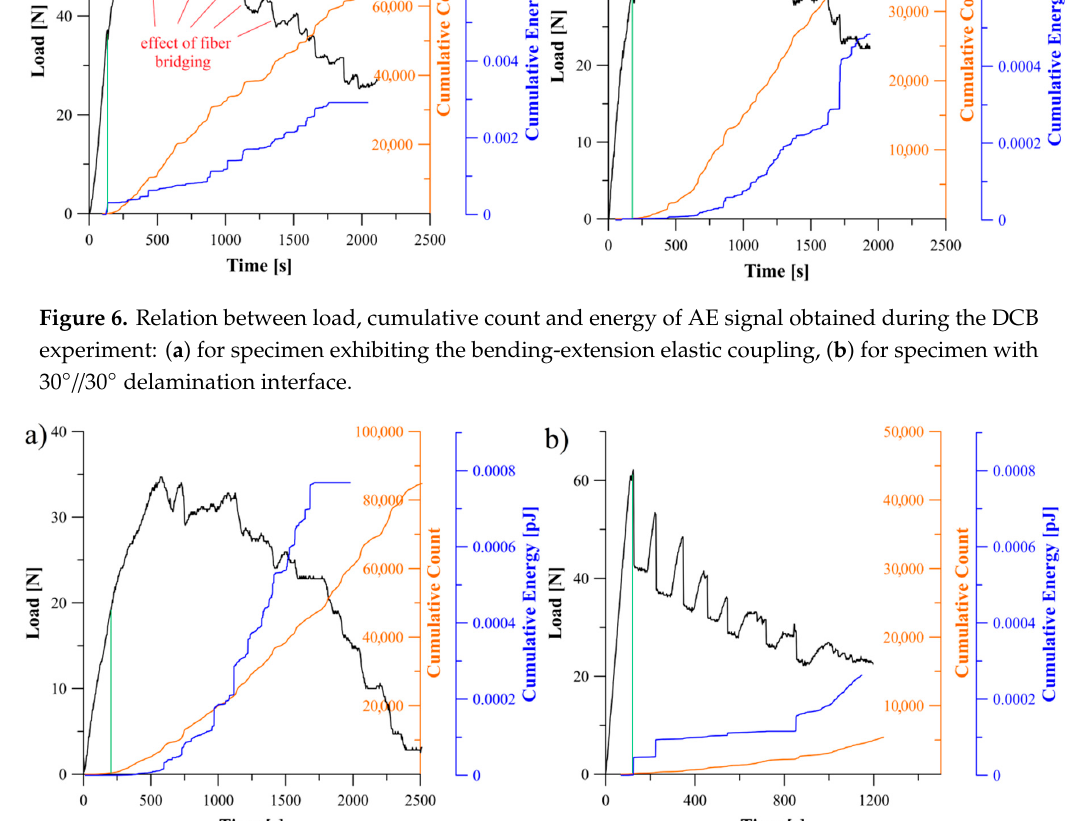
Figure 7. Relation between load, cumulative count and energy of AE signal obtained during the DCB experiment: ( a ) for specimen with 45°//45° delamination interface, ( b ) for UD laminate.